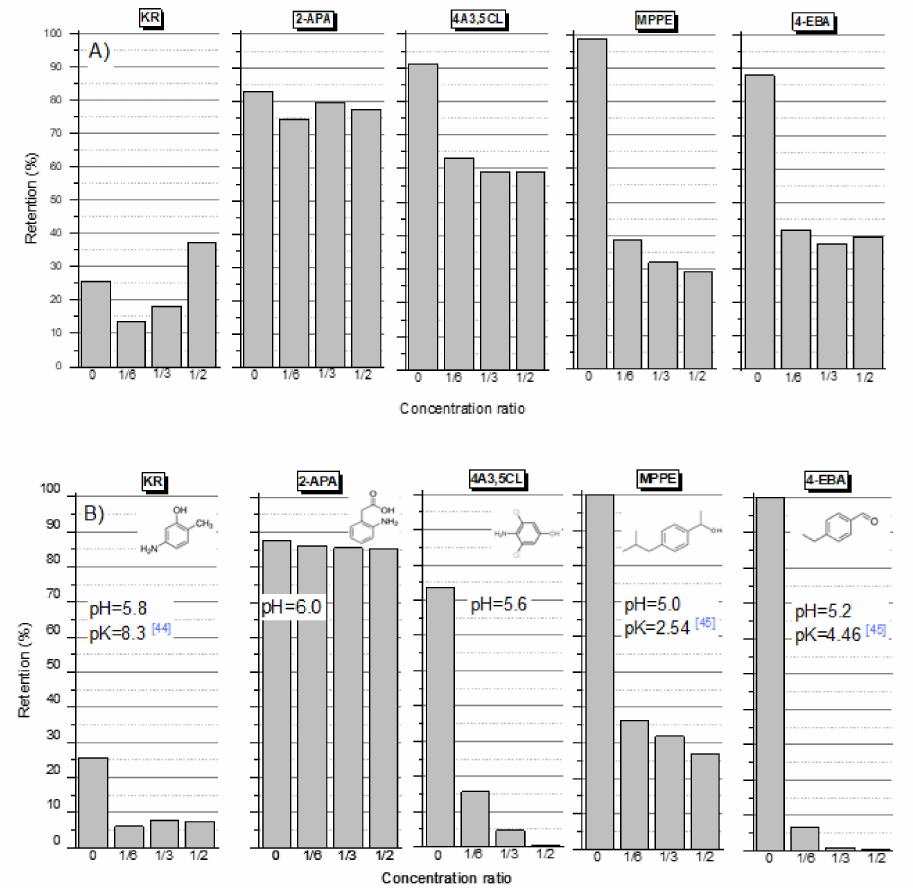
Figure 3. Retention value depending on the concentration ratio for selected compounds: ( A ) initial pH = 5–6; ( B ) pH = 8 (NaOH); membrane HL, pressure 10 bar, temp. 30 ◦ C